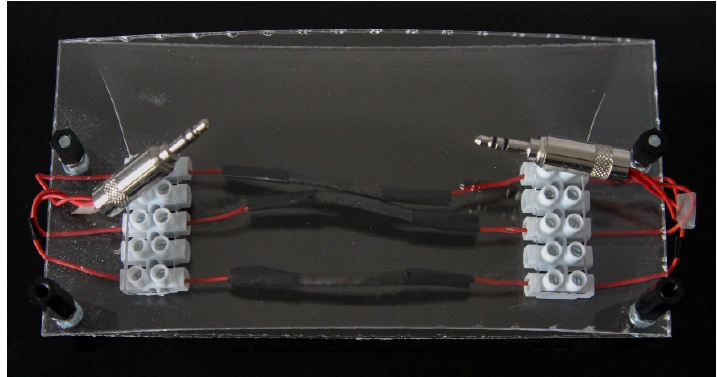
Figure 1. Example CNT/Cu audio cable manufactured using CNTs grown from polystyrene as the carbon source in the middle (black wiring) and copper wiring (red wiring) on either side to complete the circuit from one 3.5 mm stereo jack plug to another.